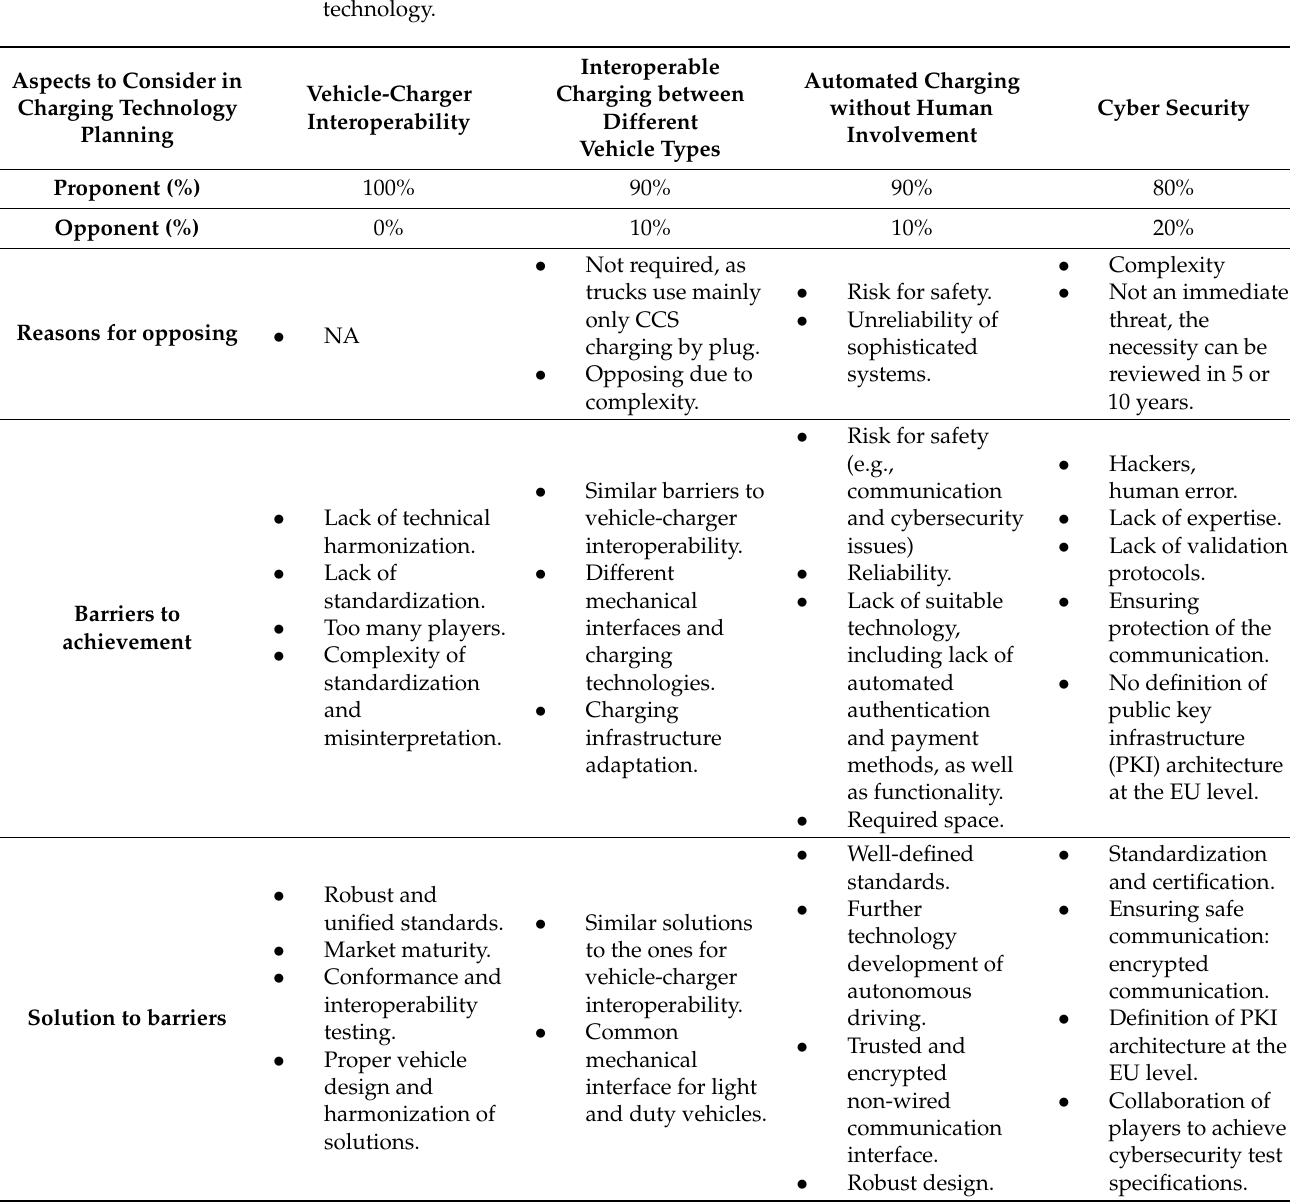
Table 8. Respondents’ opinions on including different aspects in the long-term goals of charging